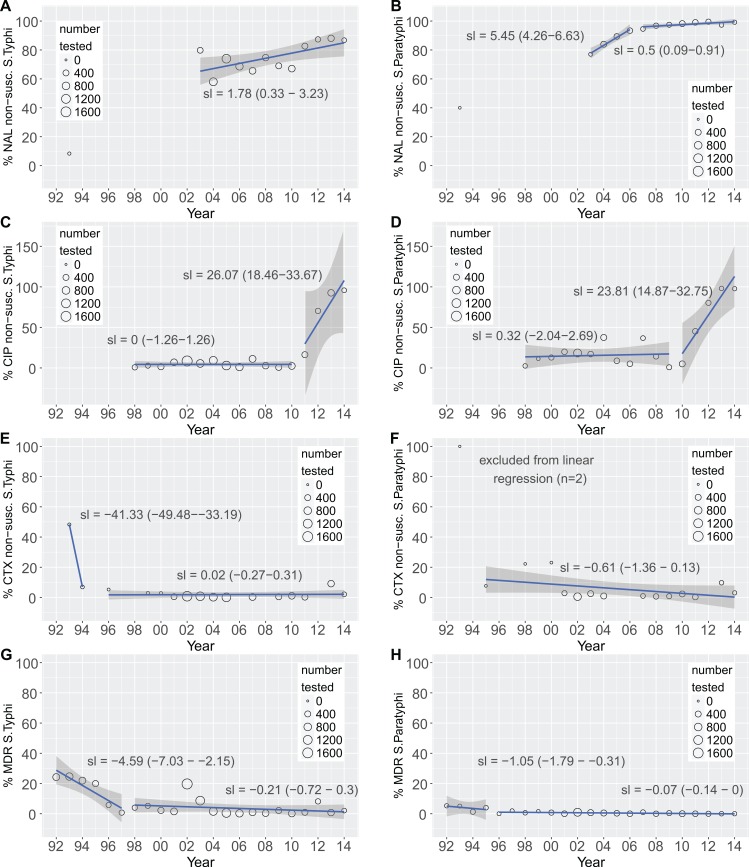
The development of non-susceptibility against selected antimicrobials and multidrug resistance. Plots showing changes in non-susceptibility against i) nalidixic acid for S. Typhi (A) and S. Paratyphi A (B), ii) against ciprofloxacin for S. Typhi (C) and S. Paratyphi (D), iii) against cefotaxime for S. Typhi (E) and S. Paratyphi A (F), and iv) multidrug resistance for S. Typhi (G) and S. Paratyphi (H) between 1992 and 2014. The linear trend-lines (blue) and 95% CI for the regression lines (shaded) are overlaid on the data points. The slope of the regression line (with 95% CI) is indicated on each plot; two regression lines are present when a breakpoint in the slope was detected.